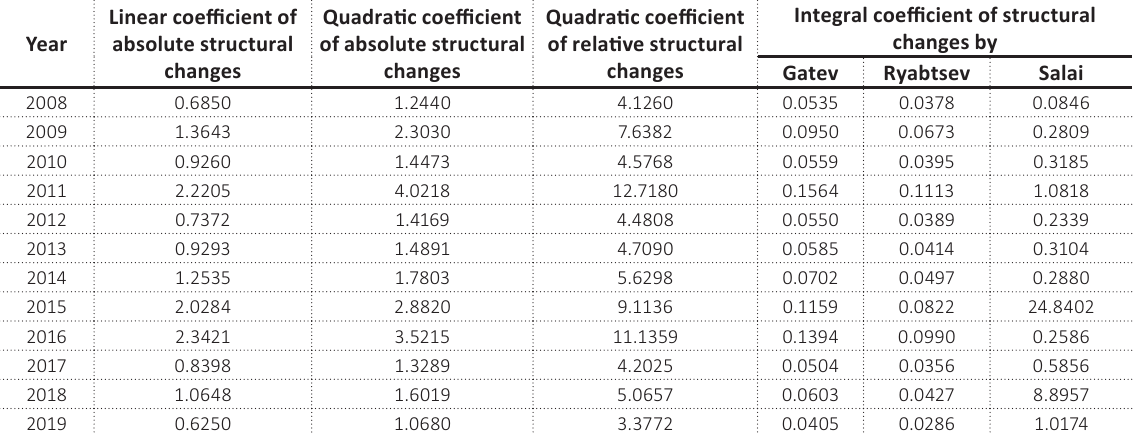
Table 2. Indicators of dynamics and variations of structural changes in the revenue side of the state budget of